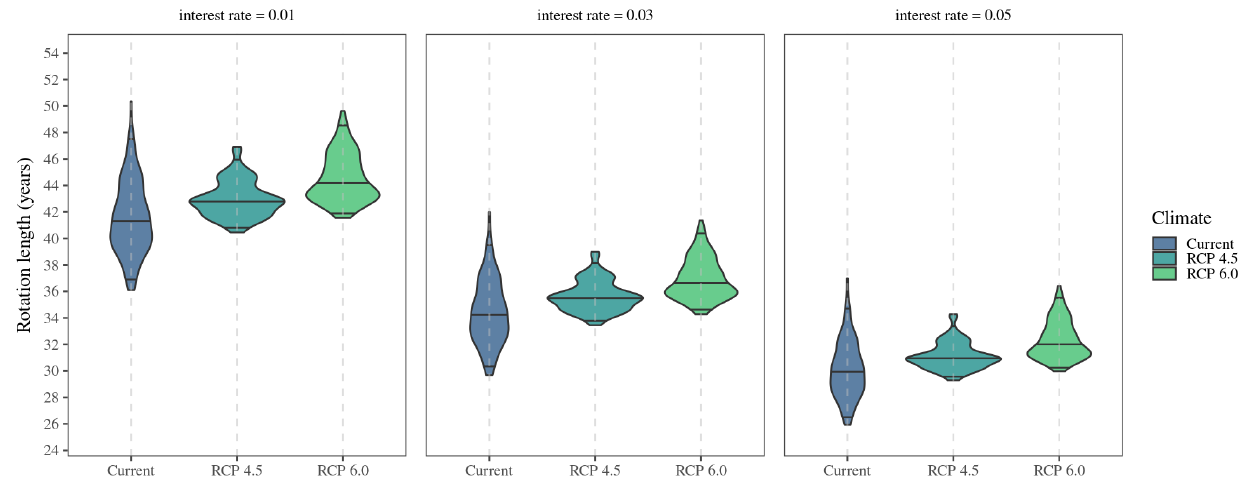
Figure 4. Violin plot of optimum rotation length vs. climatic scenario (Current productivity, RCP 4.5 and RCP